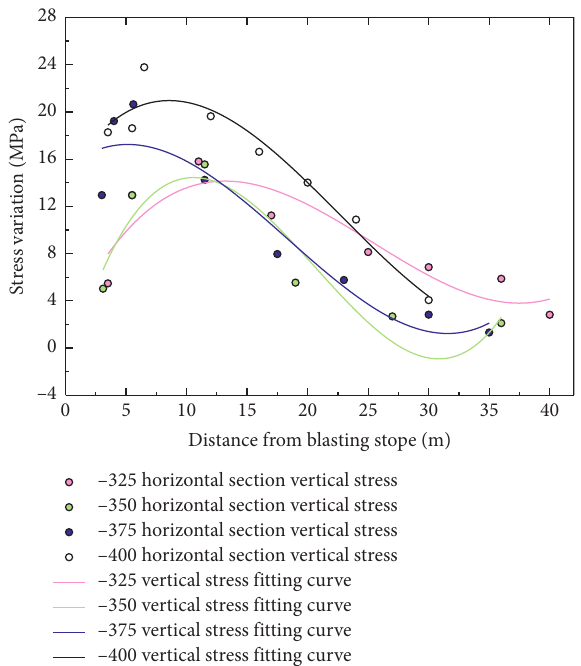
Figure 8: The law of horizontal vertical stress variation with depth in each section of